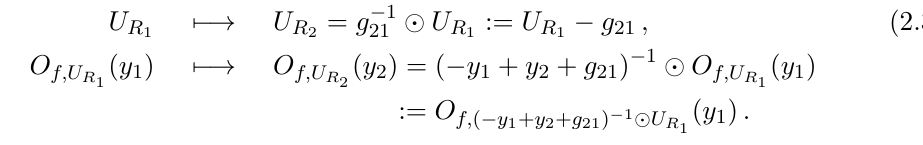
Figure 2 . Pictorial illustration of the frame change mapping the relational observables { Q { Q } . It is implemented by a field-dependent reference frame transformation, namely a transla- i | R 2 tion by the relative distance U R 2 − U R 1